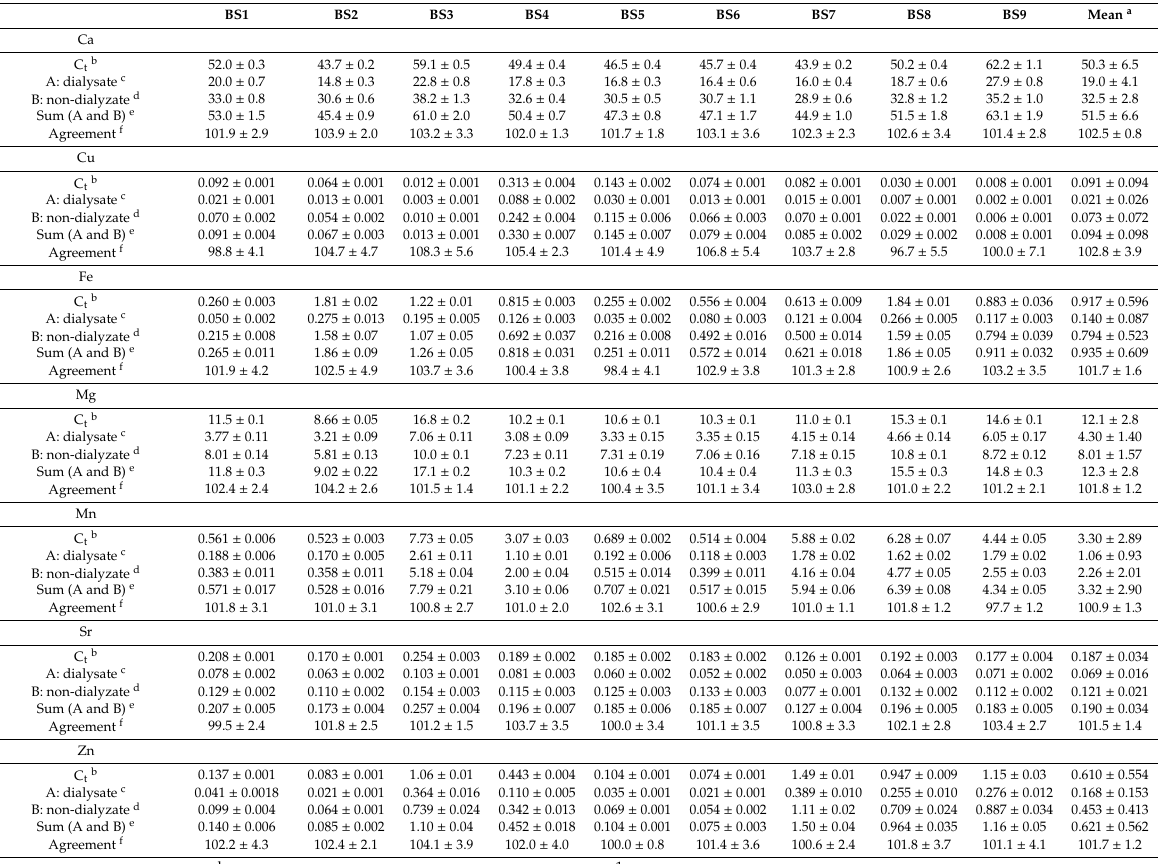
Table 7. A mass balance study for gastrointestinal digestion (GID) and mean concentrations of elements determined by ICP OES in dialyzable and non-dialyzable fractions of analyzed birch saps